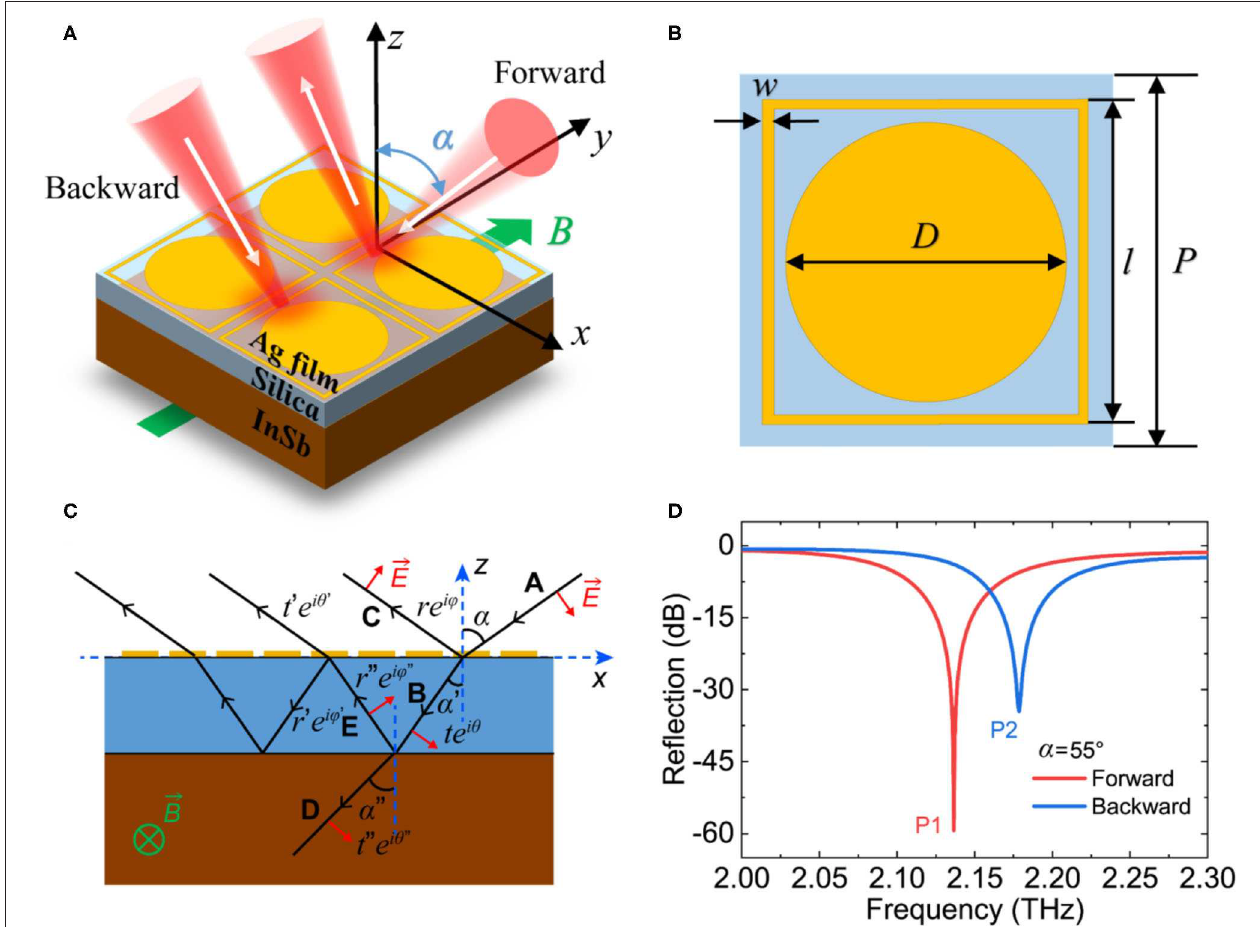
FIGURE 3 | (A) Schematic diagram of the proposed THz optical isolator for the InSb with metasurface. (B) The geometry of the unit cell metasurface, P 57 µ m, w 2 µ m and D 49 µ m. (C) Multiple reflections and interference model of the proposed THz optical isolator for the InSb with metasurface. (D) The = = reflection spectrum of the forward wave and backward wave when α